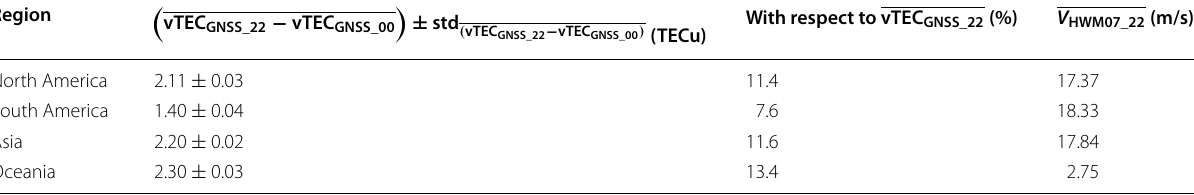
These values were derived using all data within each region shown in Fig. 2